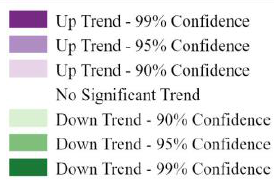
colour scale a down one. Colours vary from dark to light depending on the confidence level of the trend.